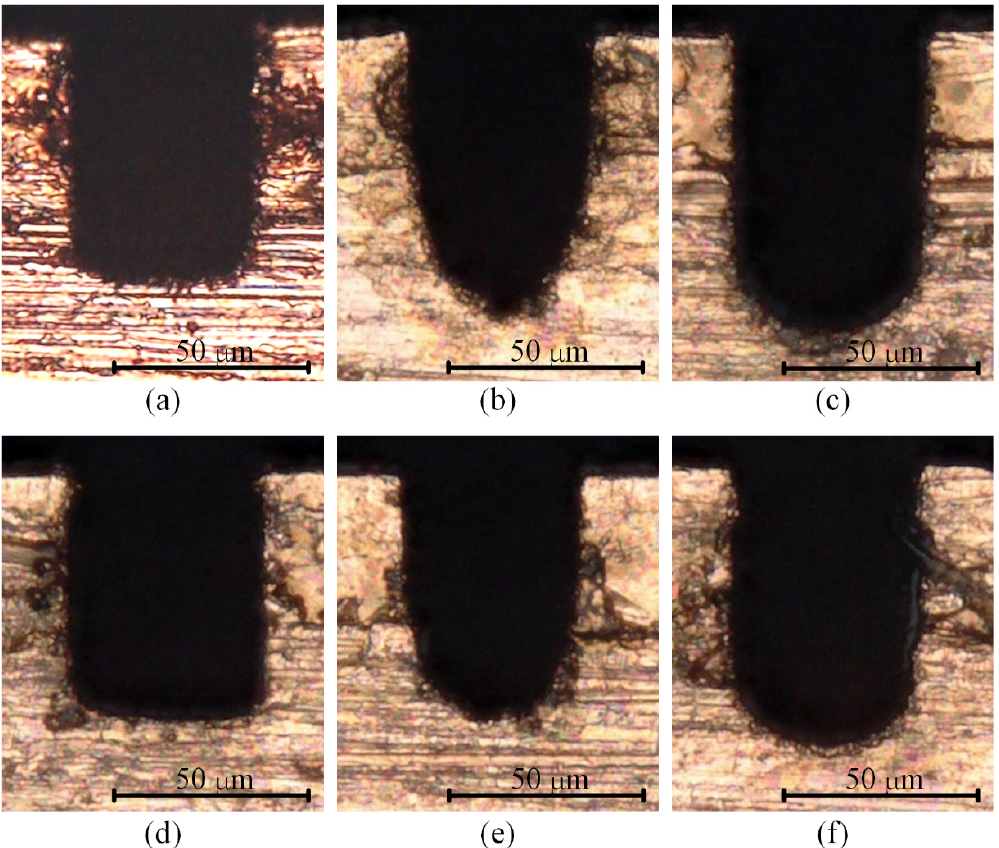
Figure 17. Optical images of the six entrance profiles of the microgrooves in Exp. 1: ( a ) cylindrical electrode-rotating mode-unidirectional path; ( b ) cylindrical electrode-nonrotating mode-unidirectional path; ( c ) square electrode-nonrotating mode-unidirectional path; ( d ) cylindrical electrode-rotating mode-reciprocating path; ( e ) cylindrical electrode-nonrotating mode-reciprocating path; ( f ) square electrode-nonrotating mode-reciprocating path.